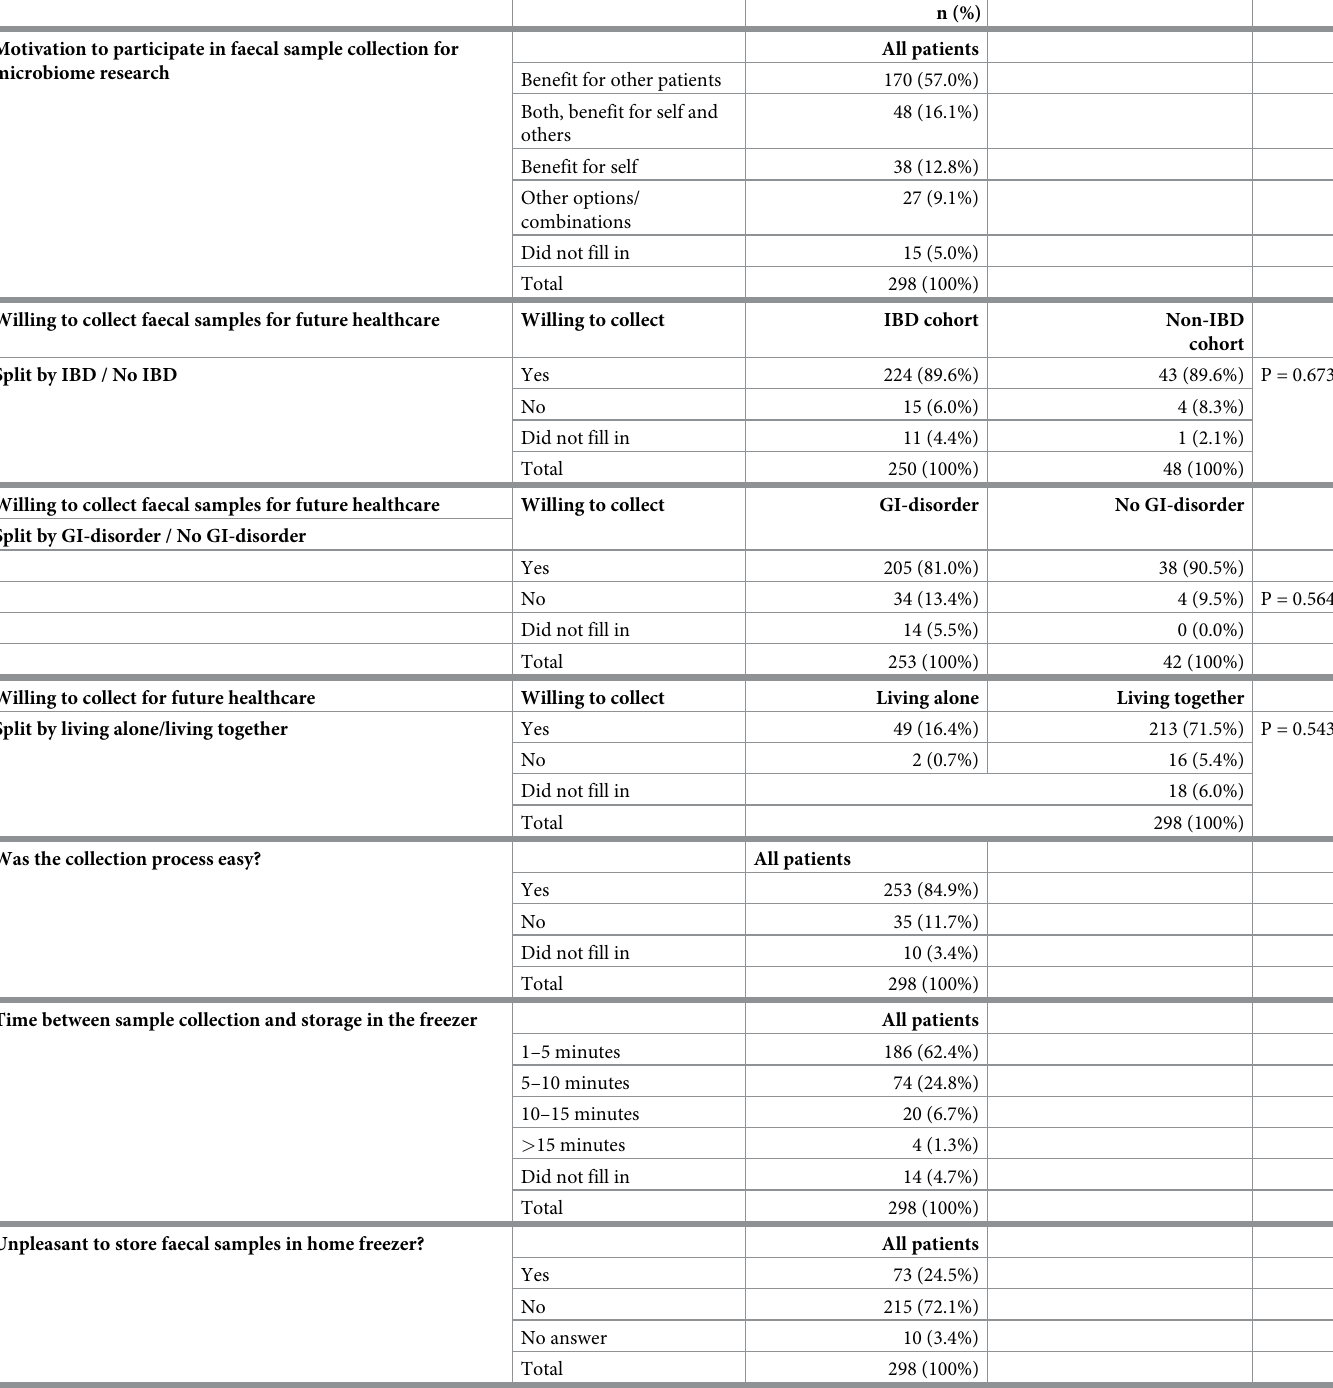
Table 1. Patient willingness to collect and freeze faecal samples and associated